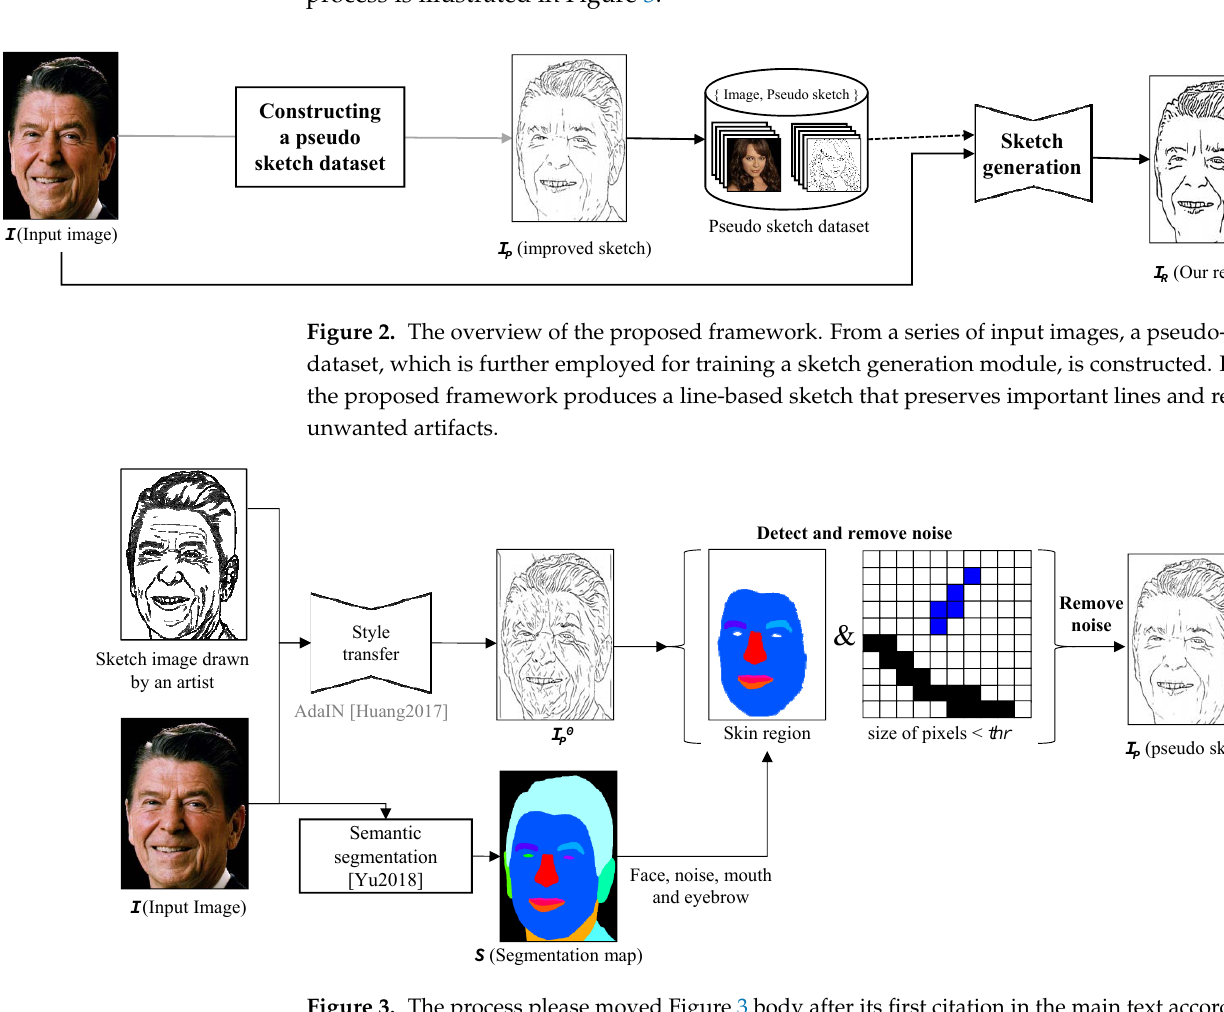
Figure 3. The process please moved Figure 3 body after its first citation in the main text according to our layout rule, the same with all figures. please confirm. of constructing a pseudo-sketch dataset. An AdaIN-based style transfer model [37] to an input image I is applied in order to extract a primitive sketch image I 0 p , which contains important lines as well as a lot of artifacts. To preserve the important lines and to diminish the artifacts, a semantic segmentation is executed and the resulting segmentation map is employed to build a pseudo sketch, I p . Improved sketch dataset is constructed from this set of I p ’s. This dataset is applied to re-train a sketch generation model, which produces the resulting sketch image, I g